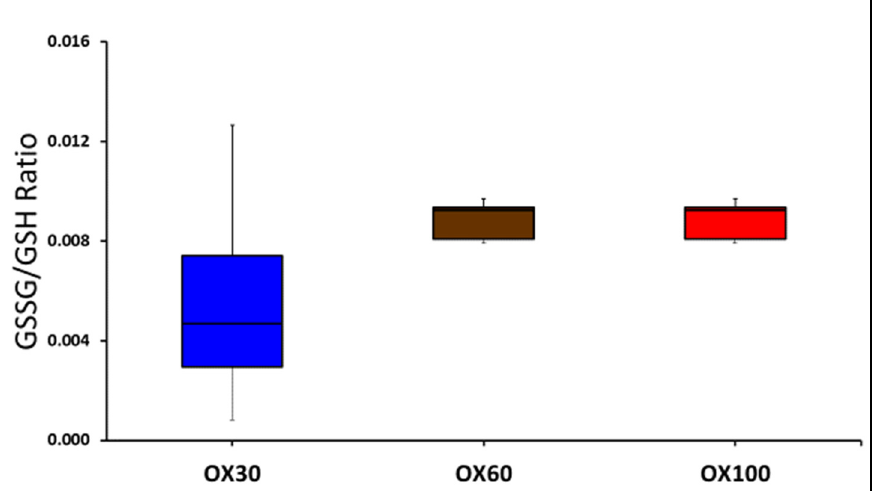
Figure 7. The oxidized to reduced glutathione ratio in the blood ( y ‐ axis) is shown between the three groups (OX30, OX60, and OX100) as box and whiskers plot. The markers of oxidative injury were not different between the groups at 10 min.